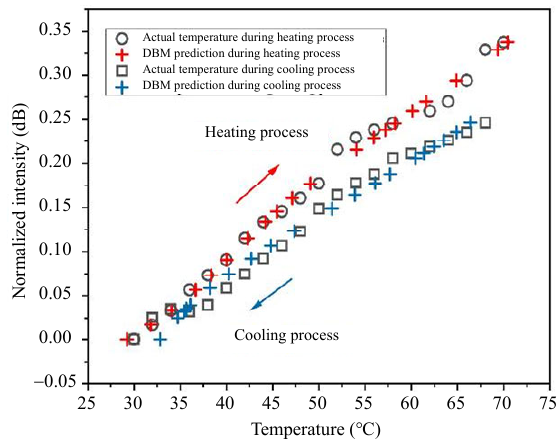
Fig. 8 Prediction skills of BPNN for temperature forecasting in increasing and decreasing sensing processes. The actual data pairs (black cubics/circles) are the same as the ones in Figs. 5 and 6 (black circles).